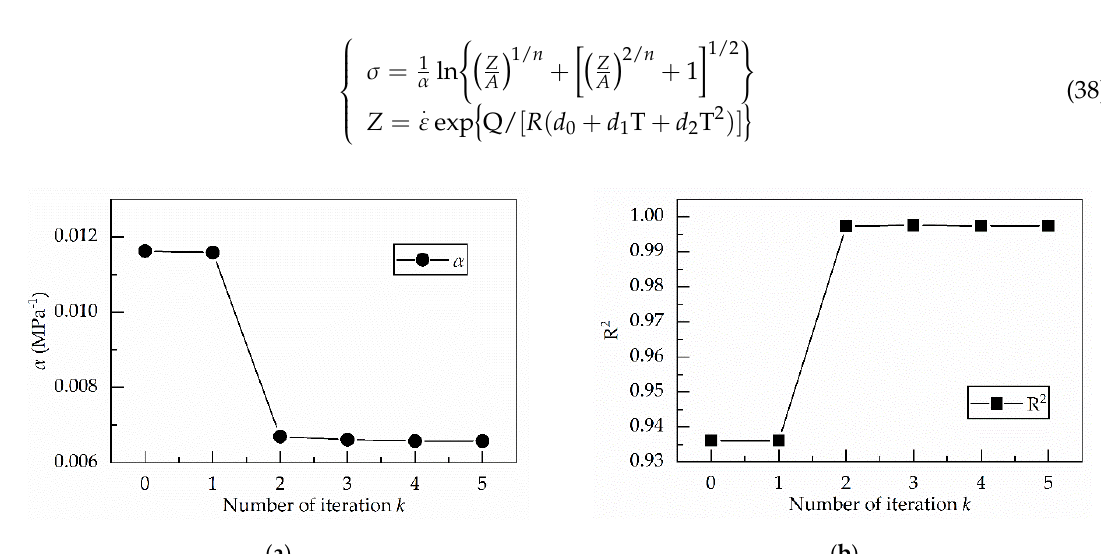
Figure 11. Based on the process in Figure 10, Variation of parameters ( a ) α ; ( b ) R 2 with the numbers of iterations k while optimizing the material constants under strain of 0.30.